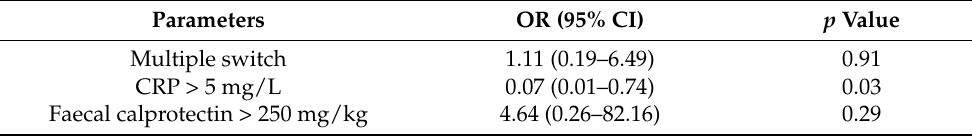
Table 3. Predictors of success of the switch at multivariate analysis.